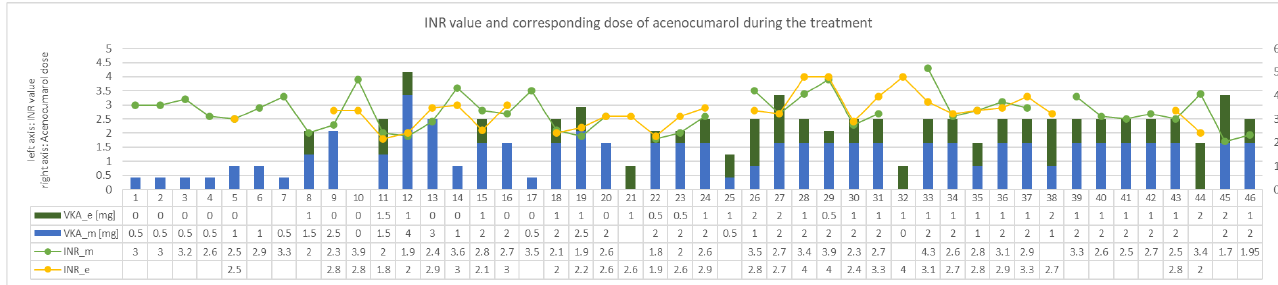
Figure 2. INR values and treatment in following days of concomitant administration of acenocumarol and rifampicin—case 2. VKA_e—dose of the vitamin K antagonist given in the evening. VKA_m dose of the vitamin K antagonist given in the morning. INR_m—INR value in the morning, INR_e—INR value in the evening. INR—international normalized ratio. VKA- vitamin K antagonist.